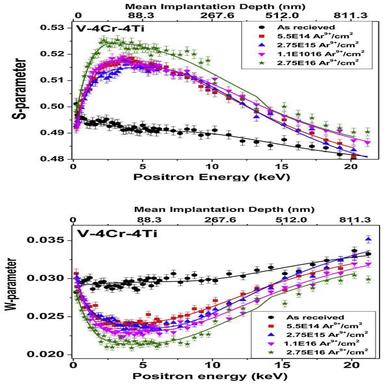
(a) & (b): S-E and W-E profiles of as received and ion irradiated V-4Cr-4Ti samples. The solid lines through the data points show the fitting of the profiles using VEPFIT.